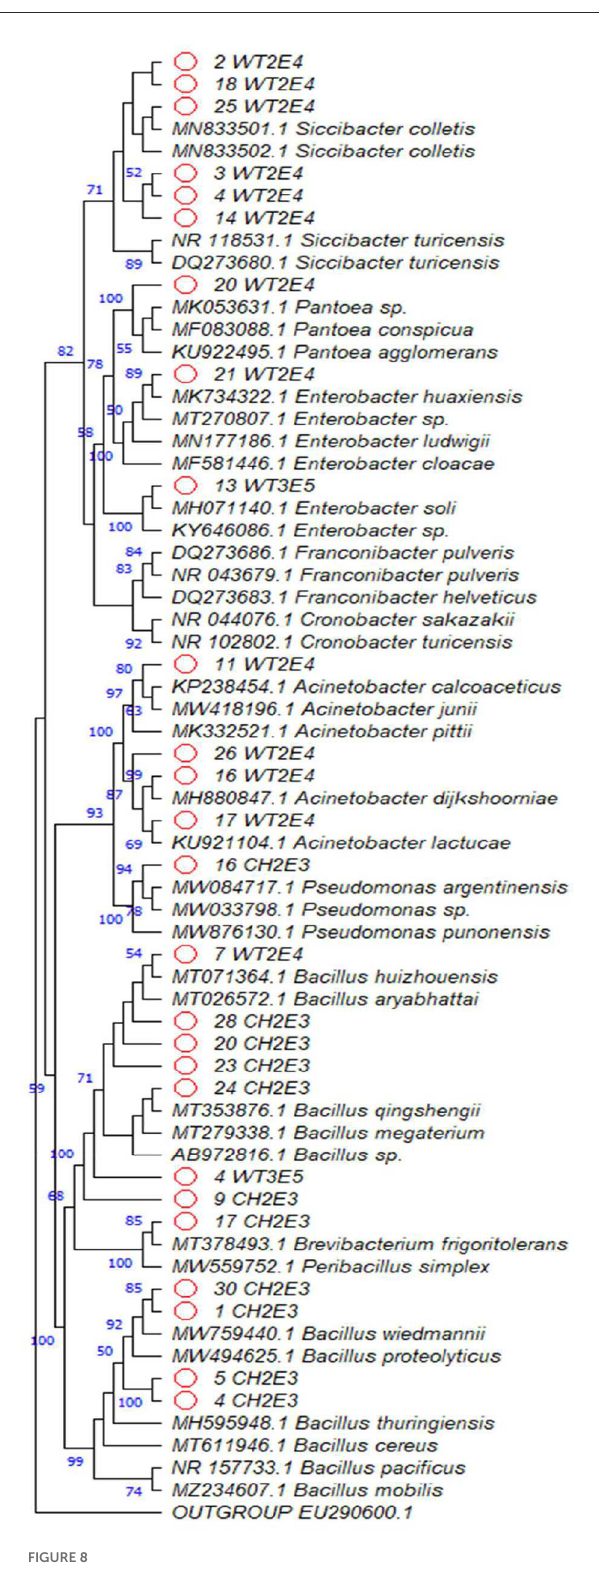
FIGURE8 Phylogenetic tree based on the 16S rRNA gene sequences (consensus alignment) corresponding to selected PGPR from alfalfa rhizosphere. The evolutionary history was inferred by using the maximum likelihood method based on the Tamura–Nei model with 1,000 bootstrap replications. The percentage of trees in which the associated taxa clustered together are shown next to the branches. Evolutionary analyses were conducted in